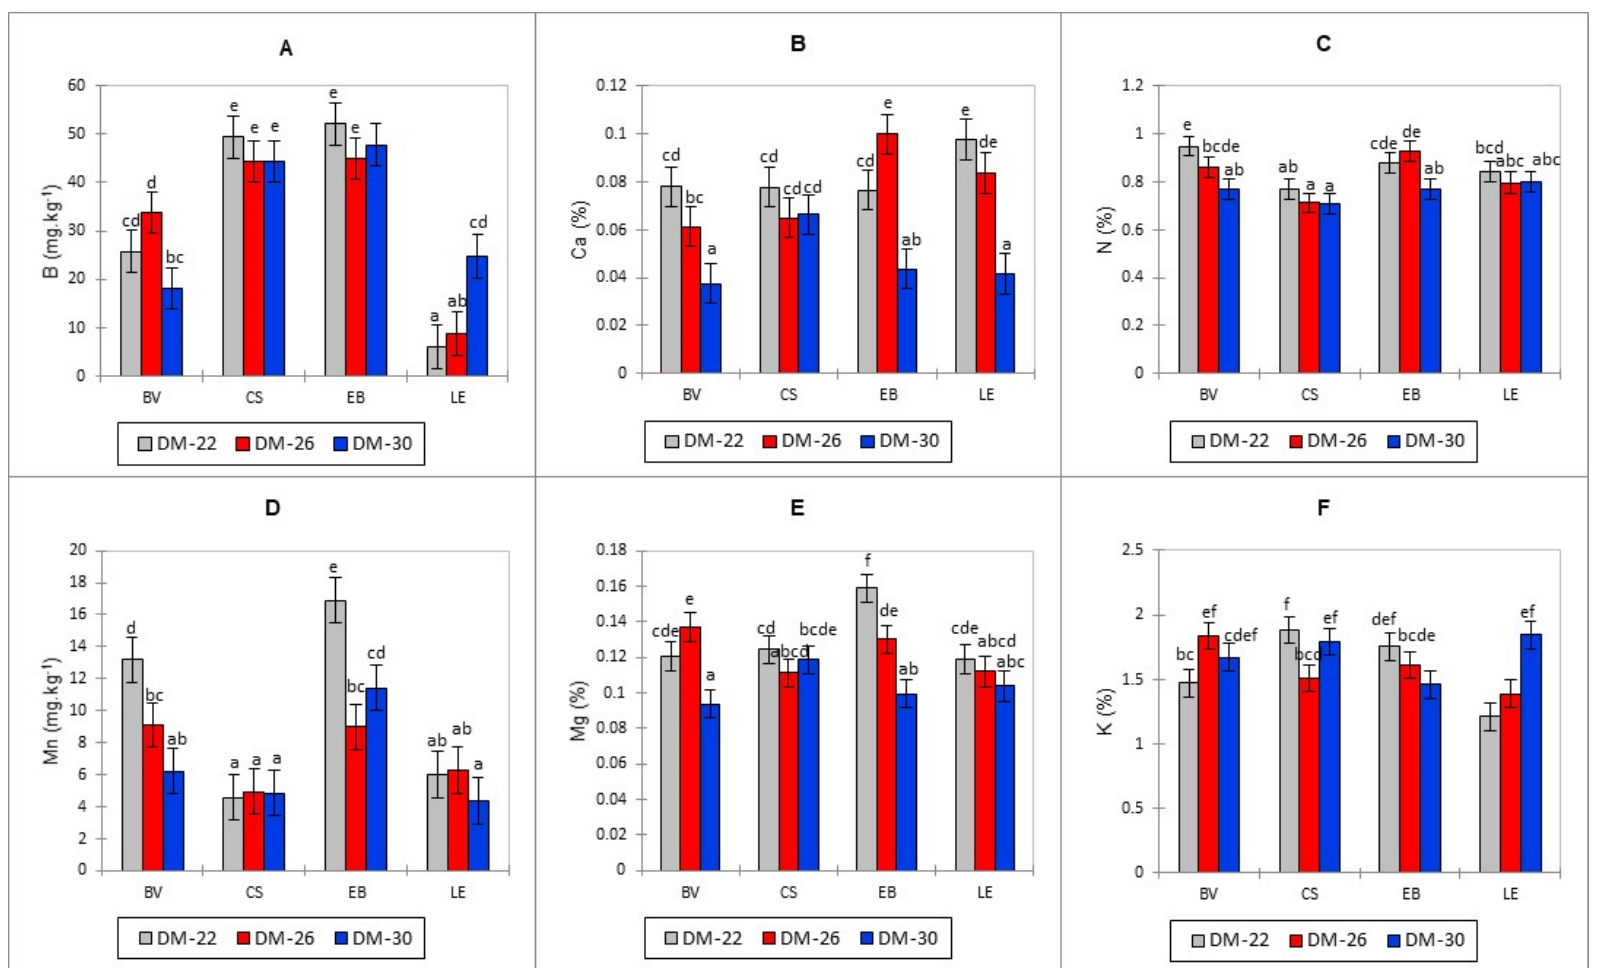
Figure 3. Mineral content by Farm and dry matter (DM-22, DM-26, and DM-30): Boron content ( A ), Calcium content ( B ), Nitrogen content ( C ), Manganese content ( D ), Magnesium content ( E ) , Potassium content ( F ) . Farms codes: EB, CS, LE, and BV.